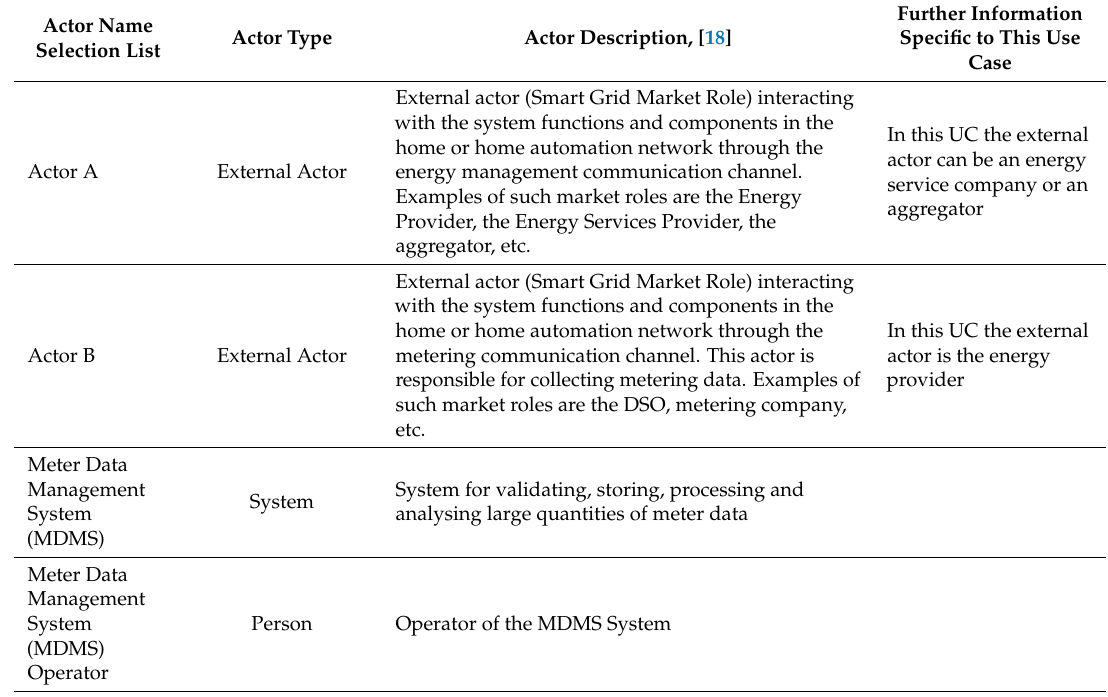
Table 1. Actors: People, Systems, Applications, Databases, the Power System, and Other